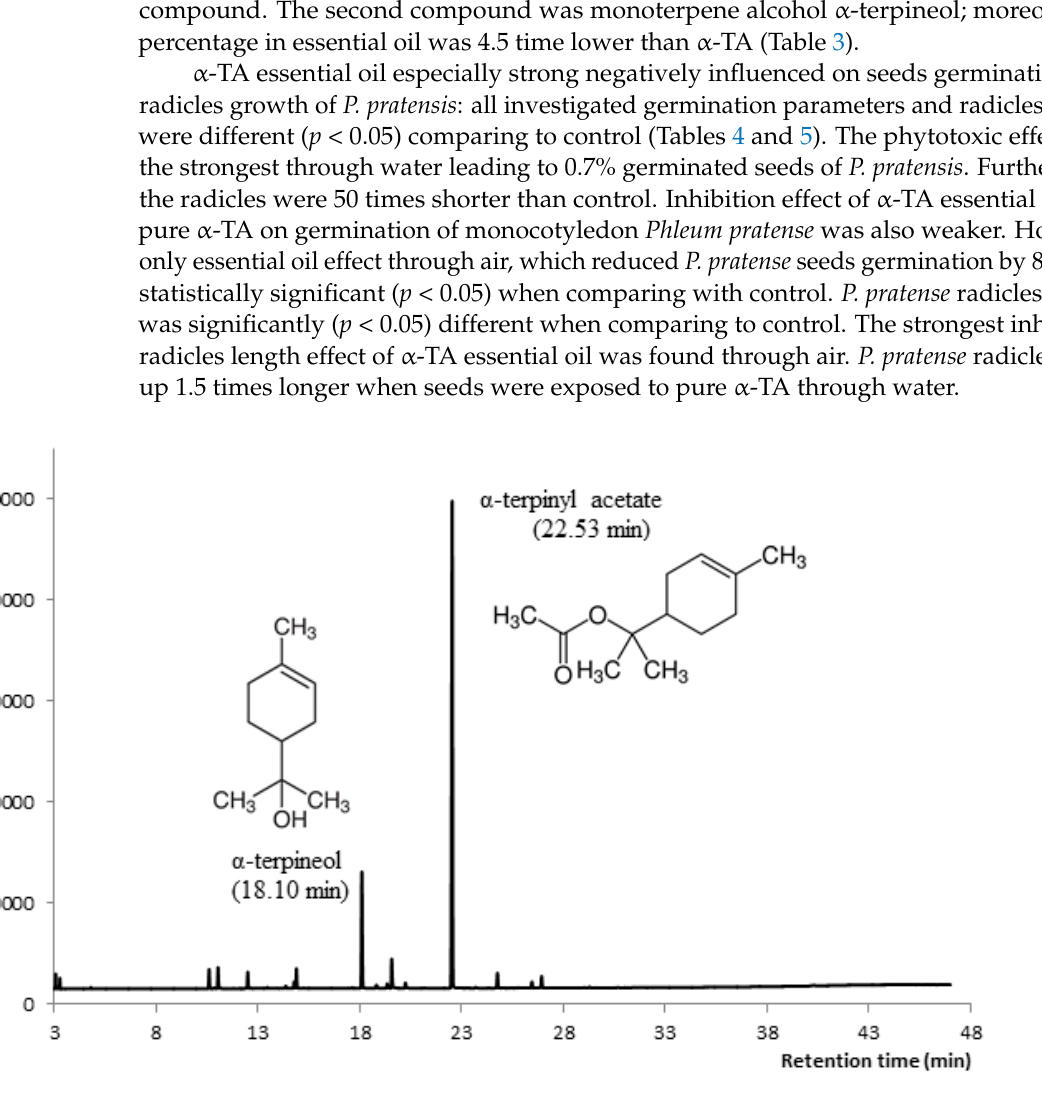
Figure 2. Occurrence of Thymus pulegioides α -terpinyl acetate in Lithuania. α -Terpinyl acetate was found in marked habitats only: habitats marked with a circle amounted ≥ 5% α -terpinyl acetate, marked with *— ≤ 5% α -terpinyl acetate in essential oil. In habitats without mark a-terpinyl acetate was not found.